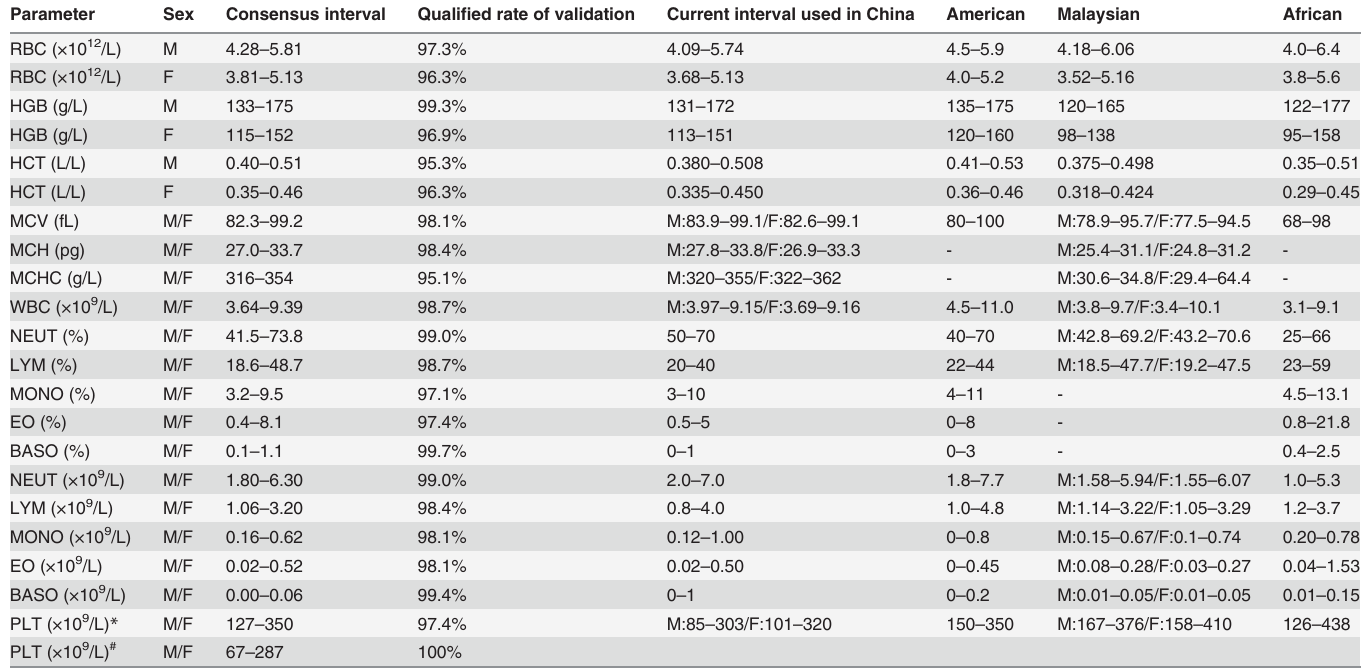
Table 3. Consensus intervals, validation rates, and comparative